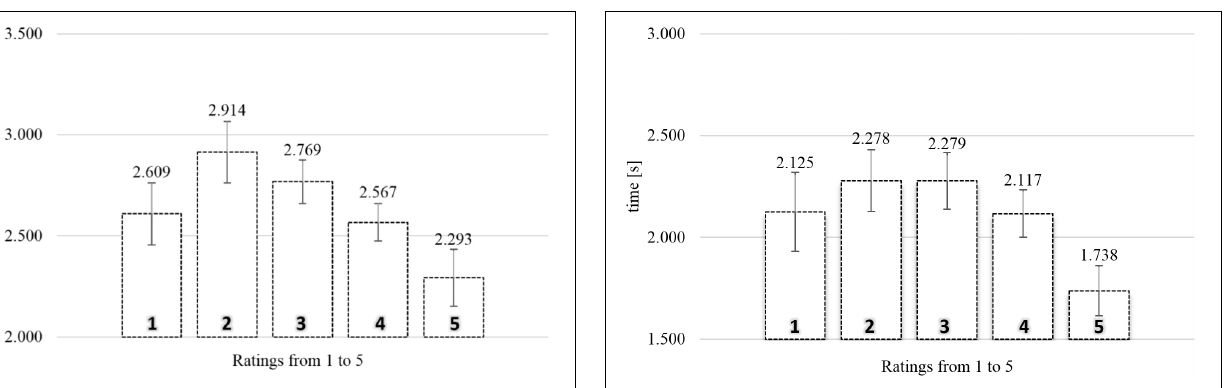
FIGURE 3 | Average actual viewing time of naturalistic food images rated from 1 (“not like at all”) to 5 (“like very much”) in the self-paced non-exclusive evaluation ( N = 44). Error bars reflect the 95% confidence interval around the